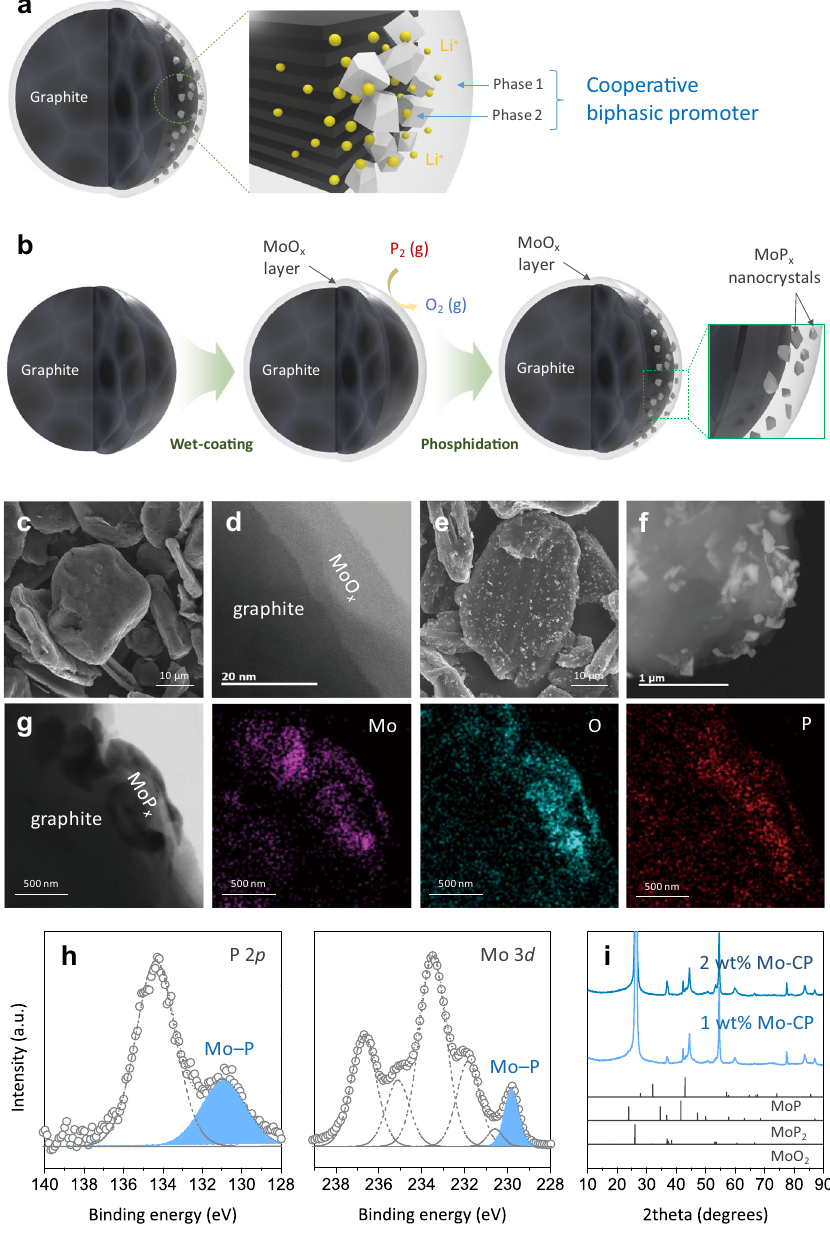
Fig. 1 Principle of cooperative promoter design and synthesis of Mo-CP/graphite. a Schematic diagram of a CP/graphite anode. The CP should (1) facilitate the formation of less resistive fi lms; (2) store Li + at high potentials; (3) exhibit small volume variation; and (4) possess high af fi nity to Li + . b Schematic synthesis of Mo-CP/graphite via vapour-induced phase transformation of MoO x to MoP x . c – f Field emission scanning electron microscopy (FESEM) and transmission electron microscopy (TEM) images of graphite particles obtained after MoO x coating ( c , d ) and phosphidation ( e , f ). g – i TEM image and EDS elemental mappings ( g ), XPS spectra ( h ), and XRD patterns ( i ) of (Fig. 2b) 30 . In hexagonal MoP with a tungsten carbide-type structure, each Mo atom is surrounded by six trigonal- prismatically coordinated P atoms (Fig. 2a), and favourable Li intercalating sites without structural distortion exist between P – P bonds. A maximum of four Li atoms ( δ = 0.5) can be intercalated into Li δ MoP with eight candidate sites, which leads to lattice expansion in the b - and c -axis directions (Fig. 2a,